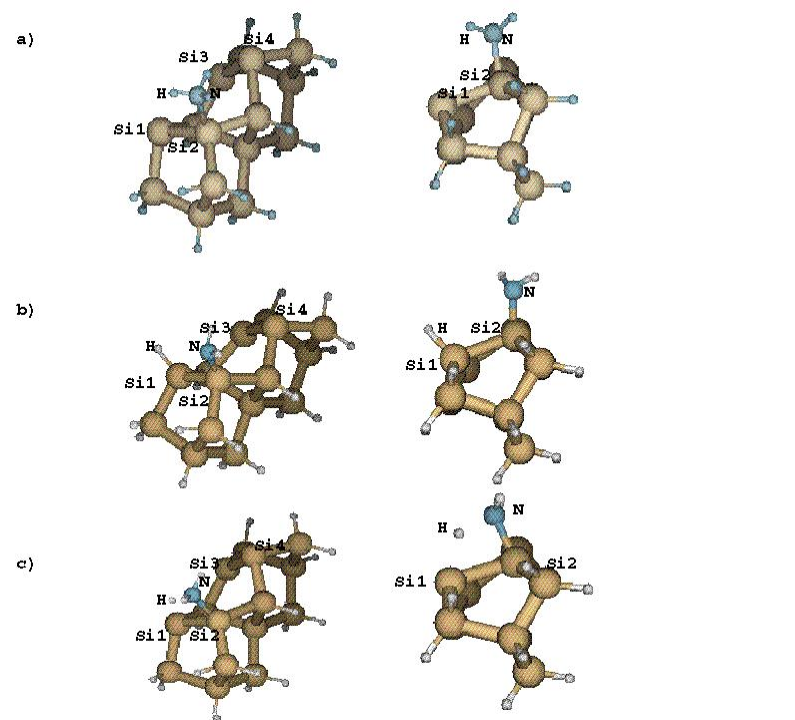
Figure 1. Calculated structures of ammonia adsorbed on a cluster-simulated (100) surface of silicon. Two different projections are given: a) adsorbed NH Si atom of the silicon dimer, c) transition state for the dissociation